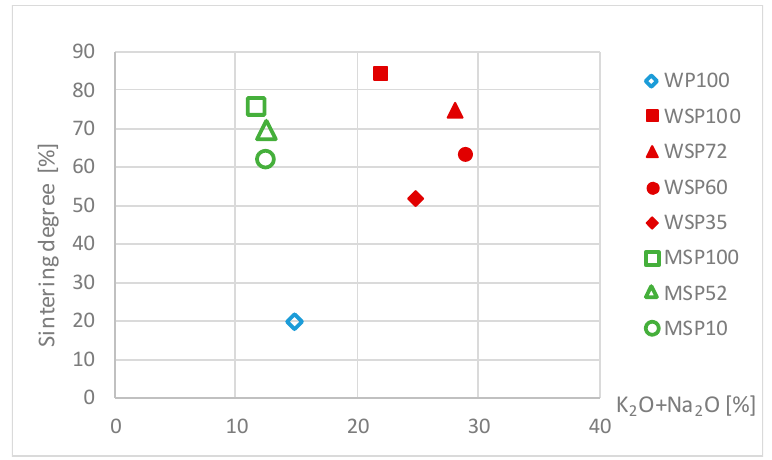
Figure 10. Mean sintering degree of bottom ash versus SiO 2 concentration in fuel preliminary anal- ysis (Table 3) for each fuel.